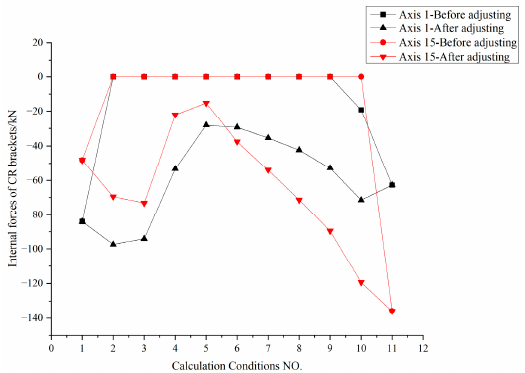
Figure 31. Maximum equivalent stress of CR before and after adjusting.